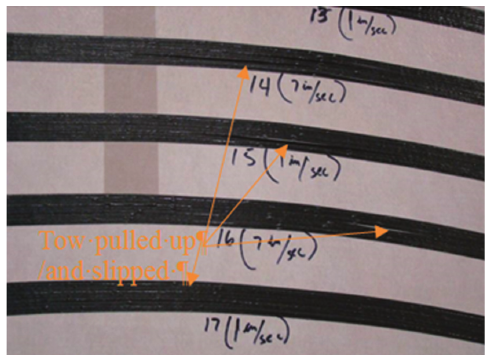
Figure 15 Highlighted area in Figure 14.